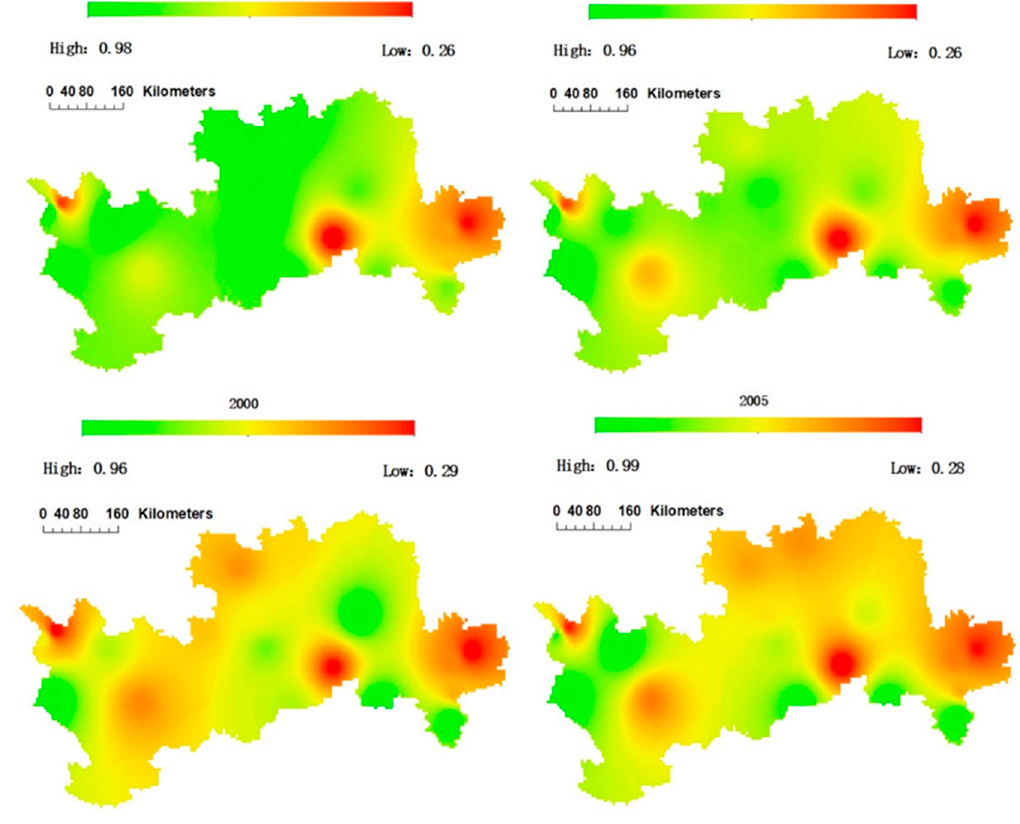
Figure 6. Spatial evolution of the water suitability of apple trees in the study area from 1990 to 2013. Figure 6 shows the spatial distribution of water suitability of apple trees from 1990 to 2013. The results show that the order of the water suitability is Sanmenxia Region (southern region) > Shaanxi Province (northern part) > Gansu Province (western part) > Yuncheng (eastern part). The low-value areas are located in Yuncheng, Tongchuan of Shaanxi Province, and Tianshui of Gansu Province. This may be due to the larger water demand of apple trees and the relatively lower rainfall in these areas. In general, Shaanxi Province is the main apple production area in China, whose apple production accounts for more than 30% of the national total. In this study, we found that the water suitability of apple trees in Shaanxi Province (north and middle area of the Loess Plateau) is relatively higher compared with other areas.